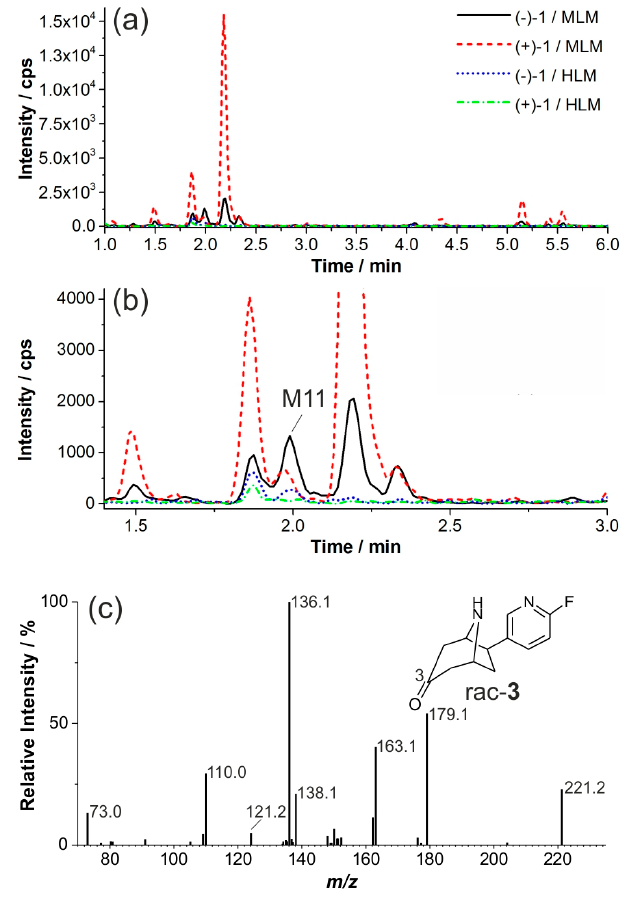
Figure 10. Formation of ketones: ( a ) multi reaction monitoring (MRM) chromatograms (222.1/110.0) of extracts resulting from incubations of both (+)- 1 and ( − )- 1 with liver microsomes (37 °C, 90 min); ( b ) enlarged detail of ( a ); and ( c ) enhanced product ion (EPI) spectrum of rac- 3 (product of m / z 221.1, CE 33, CES 0).